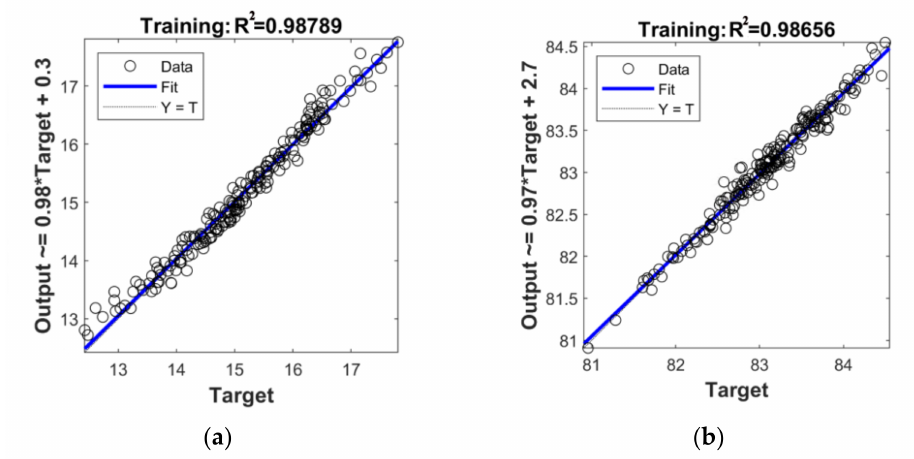
Figure 9. Regression analysis of surrogate models. ( a ) R 2 of head. ( b ) R 2 of